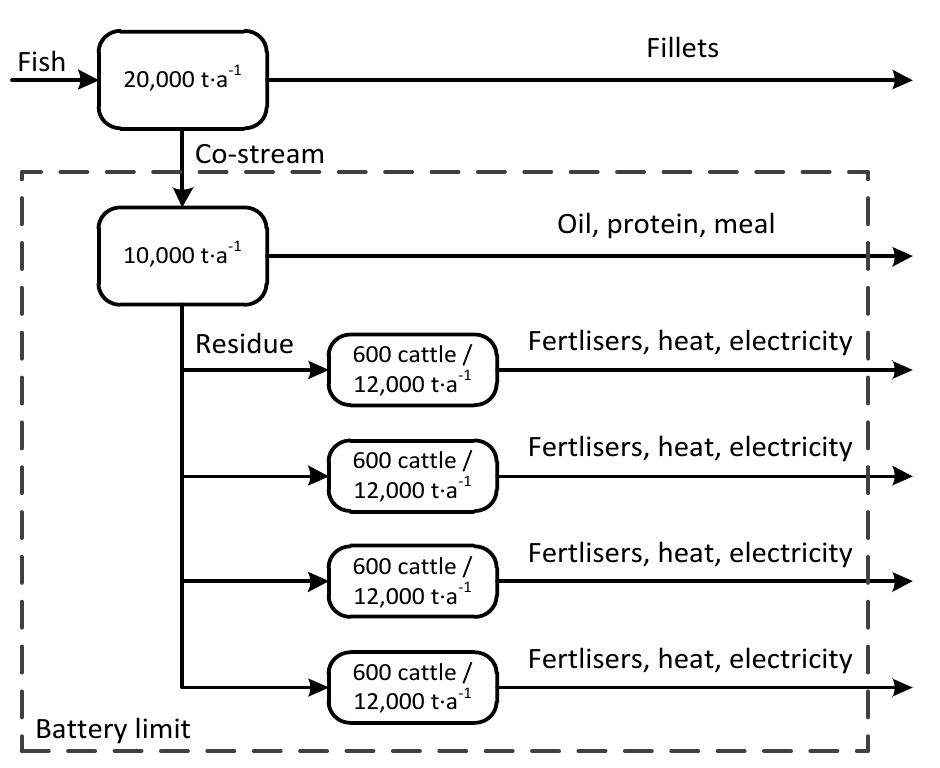
Figure 1. Battery limits of the modelled system in this study.